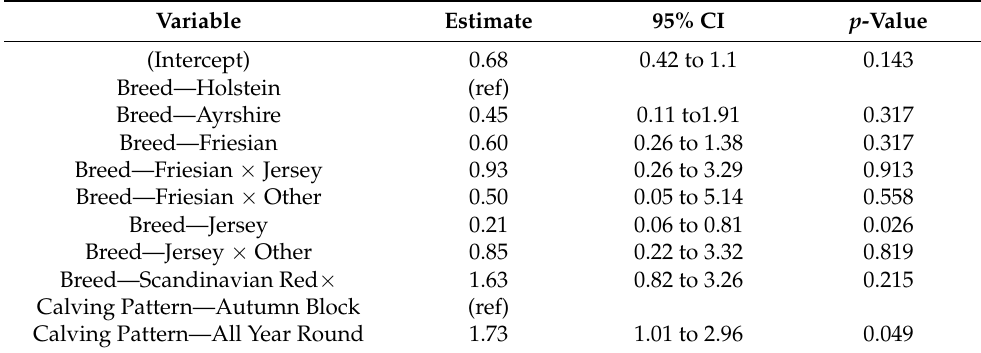
Table 1. Results of the generalised linear mixed model for variables associated with the risk of dairy heifers ( n = 492 on 11 farms) showing clinical signs of diarrhoea in their first nine weeks of life. Estimate is exponentiated to give odds ratios for diarrhoea being present. Variable Estimate 95% CI p -Value (Intercept) 0.68 0.42 to 1.1 0.143 Breed—Holstein (ref) Breed—Ayrshire 0.45 0.11 to1.91 0.317